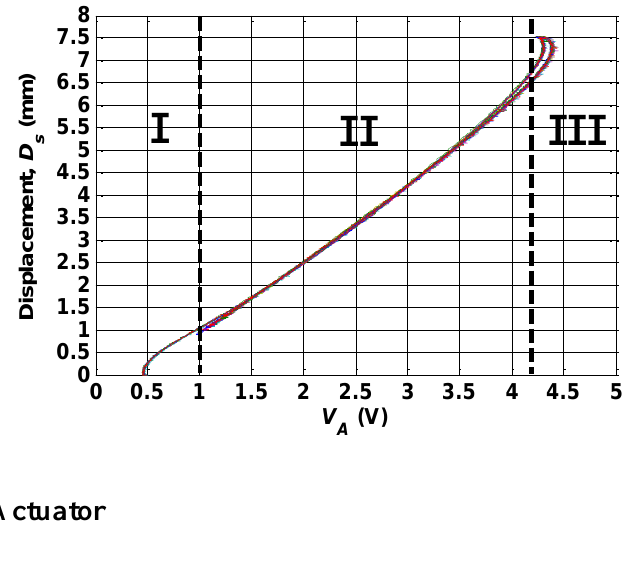
versus V for 10 experiments. s A